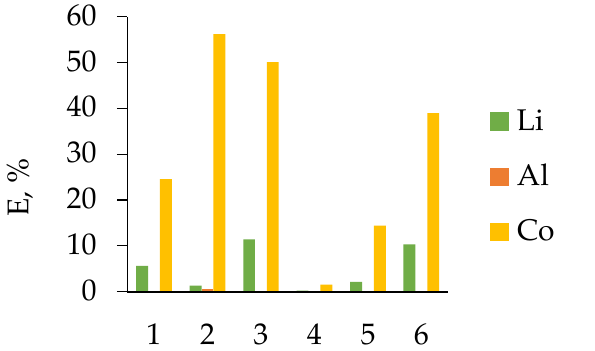
Figure 5. Extraction of Li(I), Co(II) and Al(III) ions with HDES 1 from the raffinate obtained at the 1st stage: 1–3—O/A = 1/1, 3–5 M HCl; 4–6—O/A = 1/5, 3–5 M HCl.